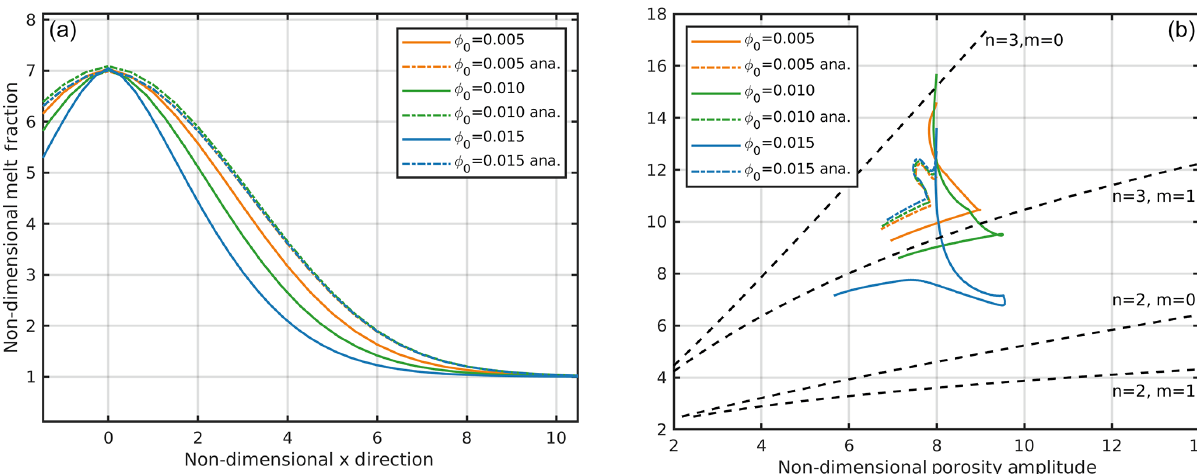
Figure 8. (a) Horizontal profiles through ascending waves and (b) dispersion curves with different background porosities but the same non- dimensional amplitude of 7. The dot-dashed curves were calculated with the simplified analytical viscosity law ( m = 1). The solid lines were calculated with a viscosity law based on 100% films and an aspect ratio of